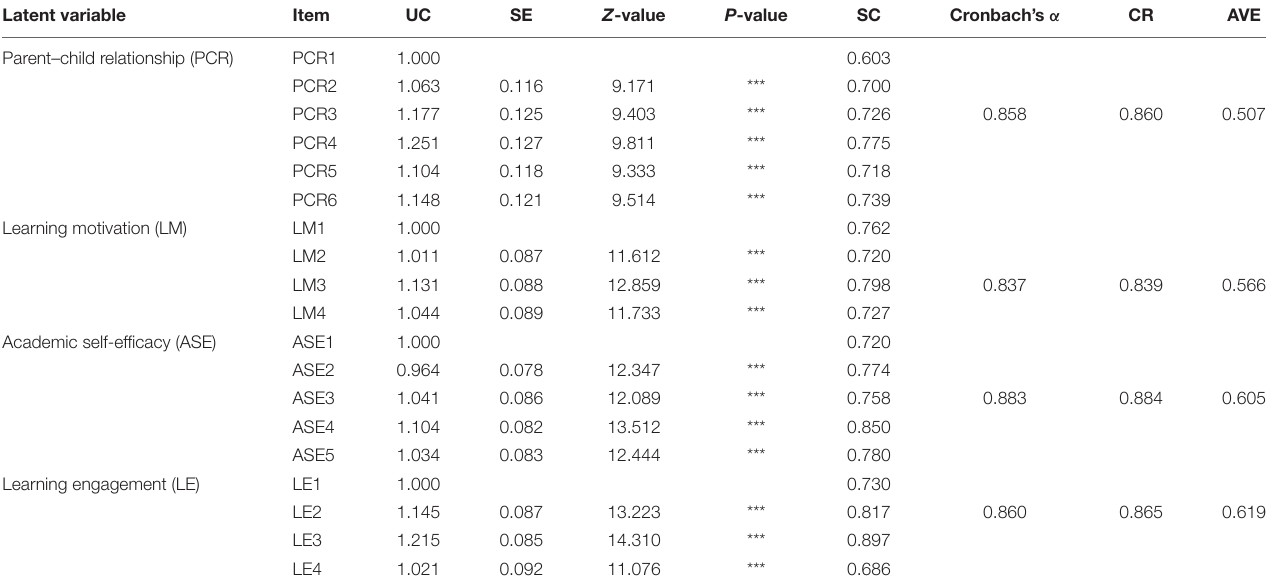
TABLE 2 | Reliability and validity examination.